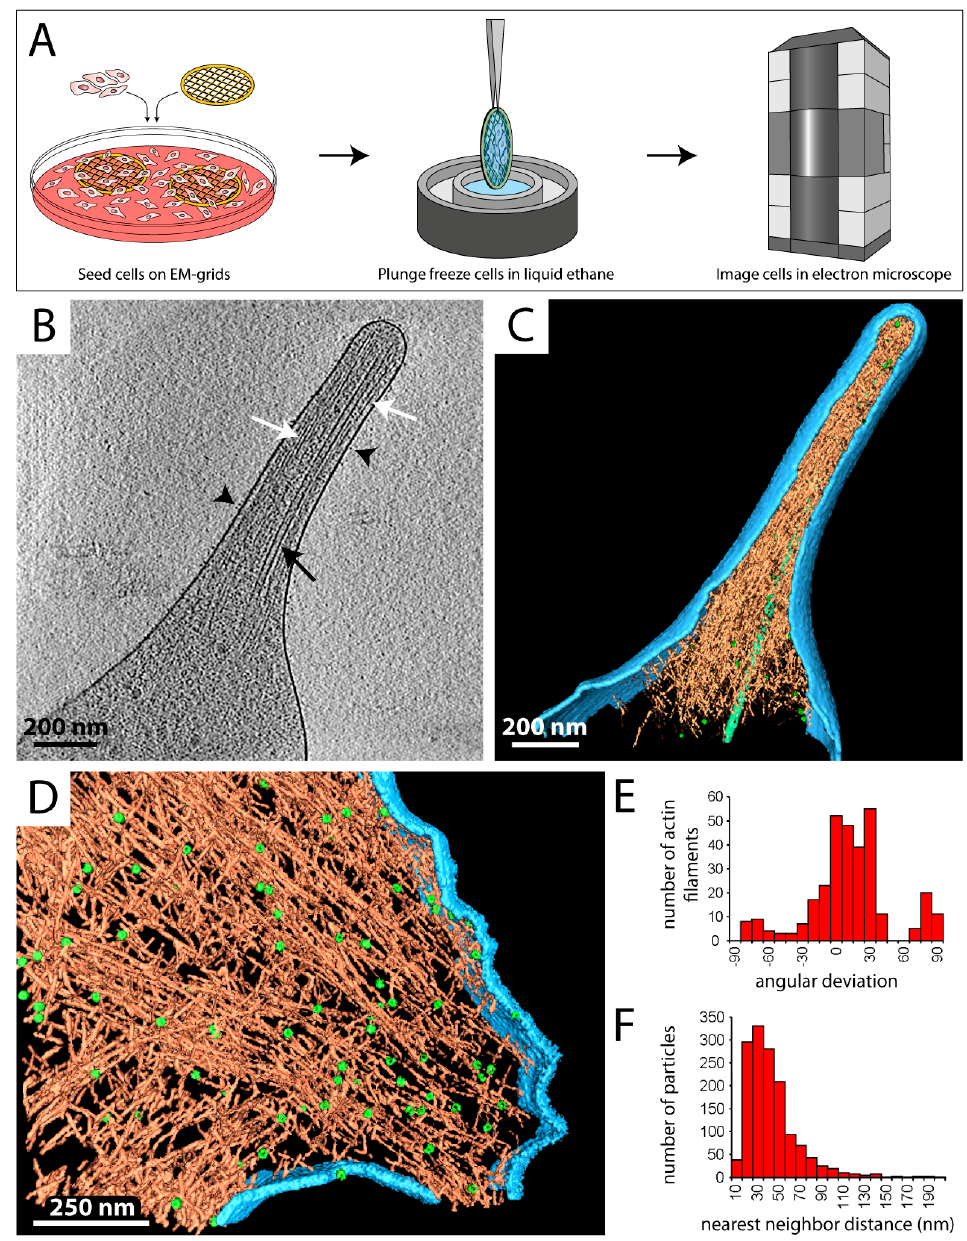
Figure 2. Investigating the cellular periphery by cryo-ET. ( A ) Eukaryotic cells are directly grown or spread on gold EM grids (left), plunge frozen (middle), transferred to the electron microscope, and imaged at cryogenic temperature (right). The cell periphery is subjected to data acquisition by cryo-ET. ( B ) Central x–y slice through a tomogram of a filopodium of a mouse platelet cell. Black arrowheads point at membrane proteins, presumably integrins. Actin filaments (white arrows) and a microtubule (black arrow) are detected in the cytoplasm. ( C ) Surface rendered view of the tomogram in B. Various cellular compartments were computationally segmented and displayed in different colors: plasma membrane (light blue), actin filaments (orange), adhesion-related particles (green spheres), and a microtubule (light green filament). ( D ) Surface rendered tomogram of a focal adhesion site in an ILK − / − mouse embryonic fibroblast (MEF) cell. Coloring according to C. ~90 adhesion complexes and ~320 individual actin filaments could be tracked in this adhesion site. ( E ) Histogram showing the orientation of actin filaments within the focal adhesion site in D. The angular deviation is ~10 ◦ larger than in wildtype cells. ( F ) Histogram of the distance between neighboring adhesion complexes versus the total number of particles. ( D – F ) are modified from